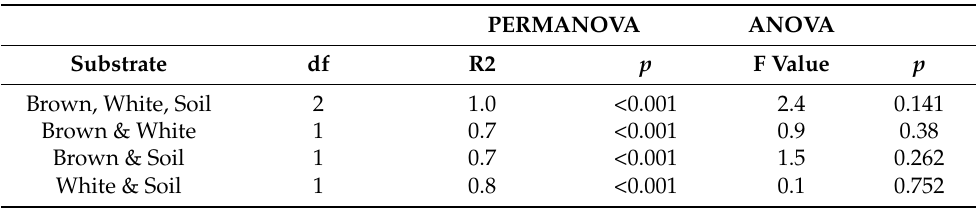
Table 2. Results of PERMANOVA comparing dissimilarities in fungal OTU composition, and ANOVA comparing dispersion.